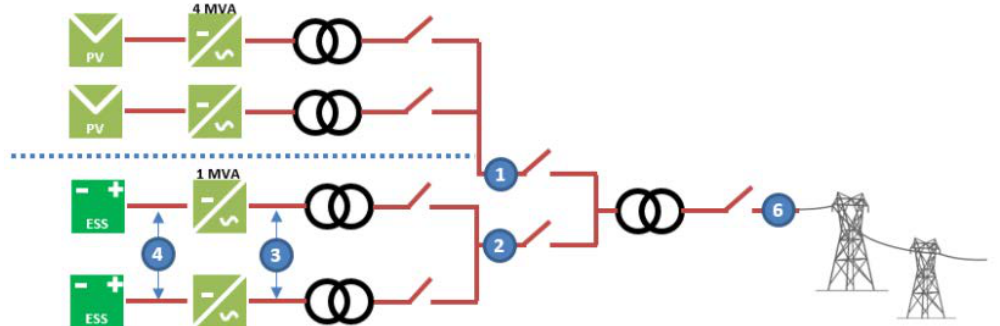
Figure 7. Single Line Diagram for AC-Coupled PVS showing the di ff erent nodes for power calculation